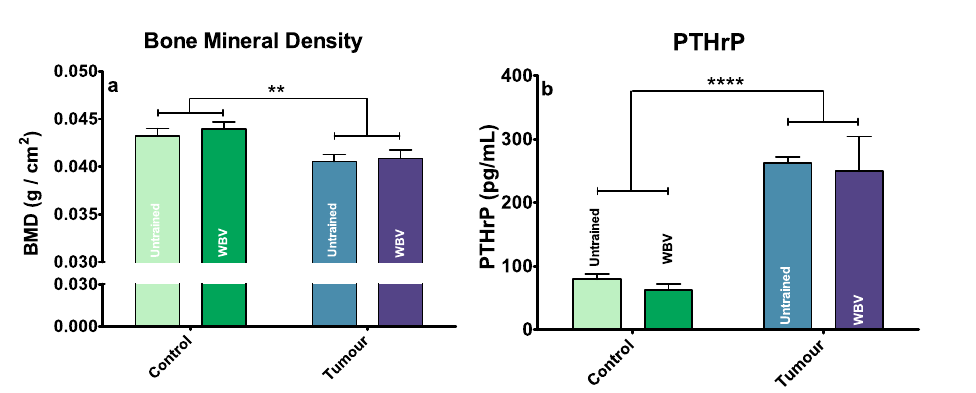
Figure 2. Front leg BMD ( a ) and plasma PTHrP ( b ) at section. Data represent mean ± sem. ** and **** indicate p < 0.01 and p < 0.001